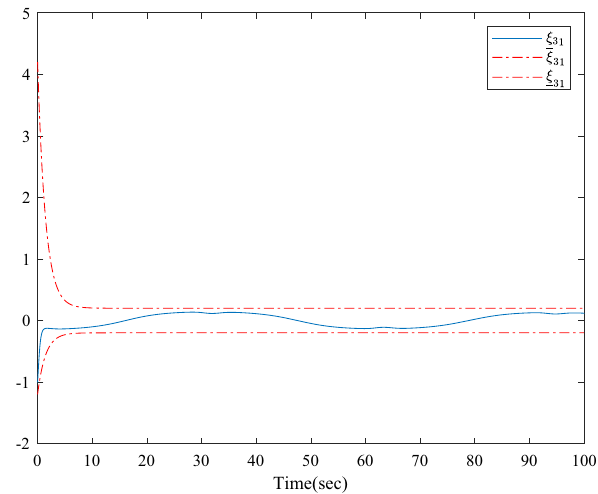
Figure 7. Error states of the following agents ξ 31 along with their bounds.